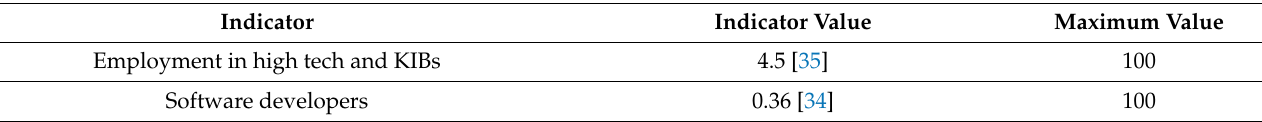
Table 5. The components knowledge creation and dissemination in the digital dimension—the startup phase of an enterprise (the table refers to the Republic of Serbia and was made in the likeness of the EIDES report). Knowledge Creation and Dissemination in the Digital Dimension of the Digital Entrepreneurial System of